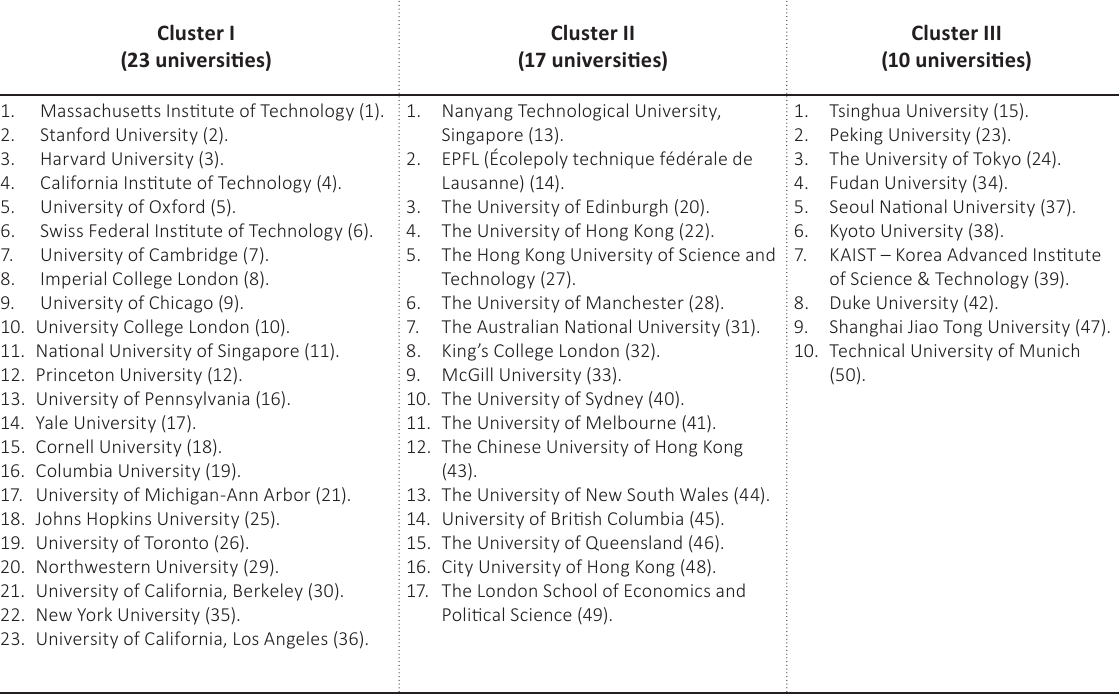
Table 3. Clusterization results of the Top 50 universities by the numerical values of the criteria for calculating QS and THE,